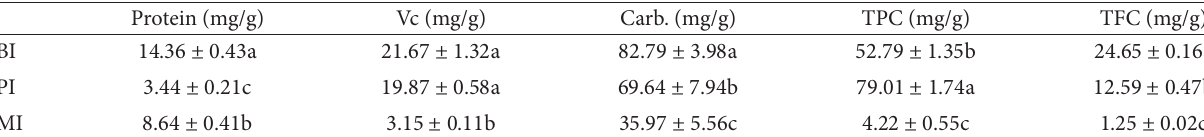
Table 1: Contents of bioactive constituents in three kinds of Hawk tea